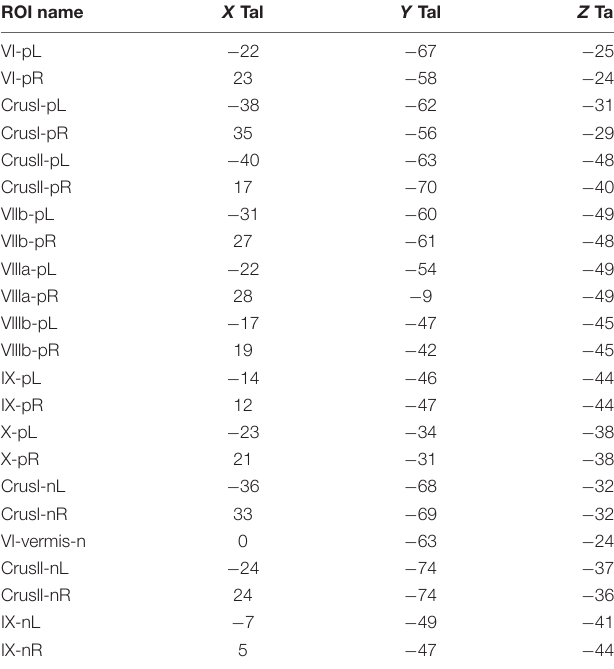
TABLE 1 | Talairach Locations of the Cerebellar